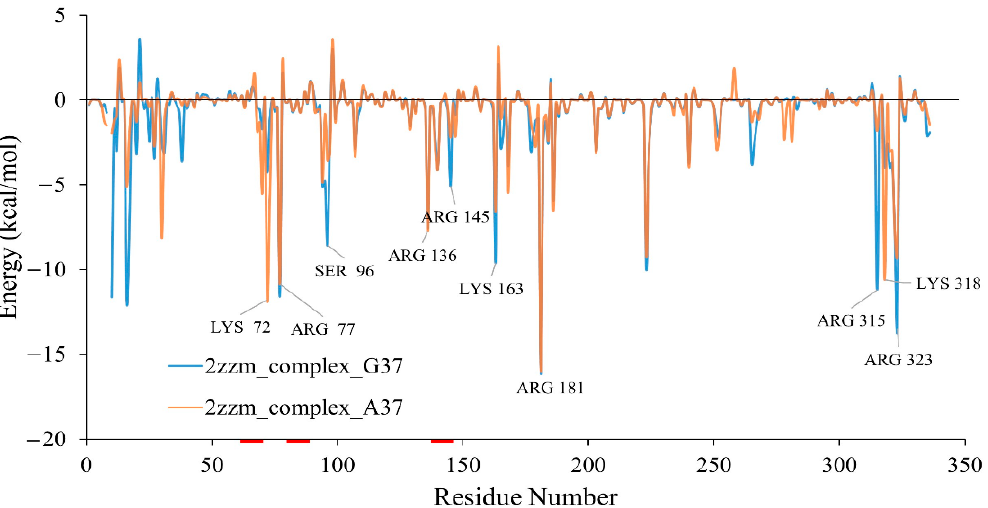
Figure 7. Interaction energy between amino acids of Trm5 and tRNA in wild-type (2zzm_complex_G37) and G37A tRNA mutation complex (2zzm_complex_A37) computed using the MMGBSA method. DOT regions are marked in red colour in the X-axis.